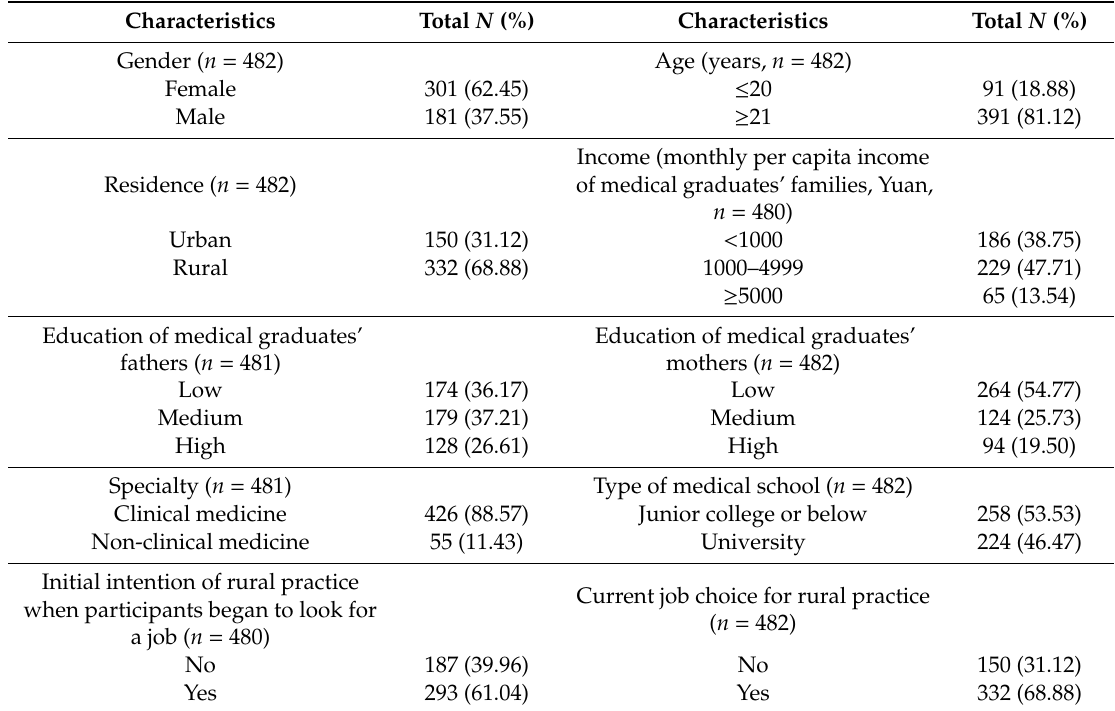
Table 1. Participants’ sociodemographic characteristics, initial intentions of rural practice, and current job choices for rural